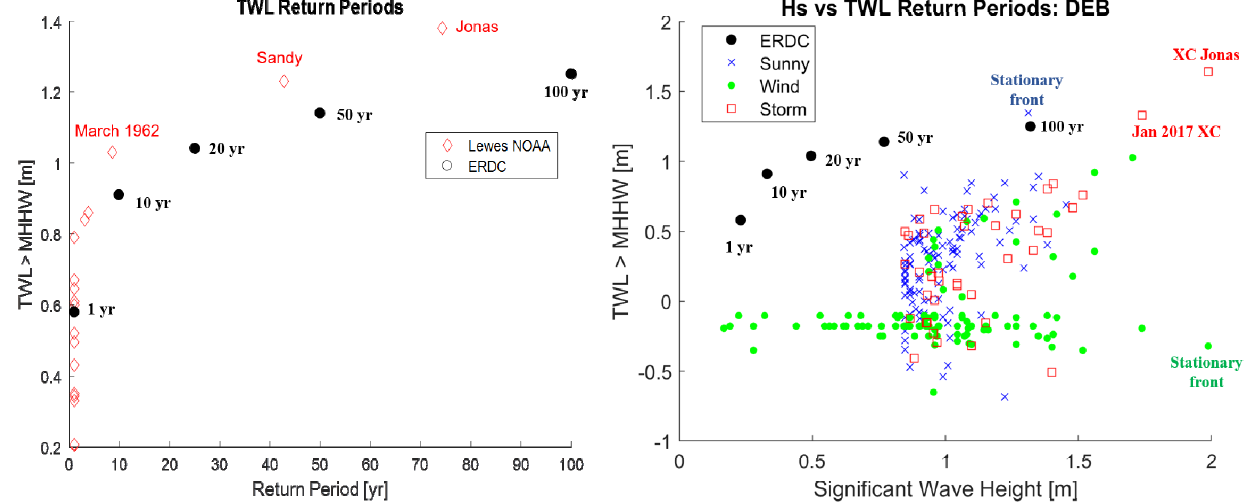
Figure 7. ( Left ) Return period plot of the total water level above MHHW for the Lewes gauge station for a selection of historical storms compared to the statistical return period values created by USACE ERDC during the NACCS project. See Appendix B for a list of storm names, dates, and values used in this figure. ( Right ) ERDC return period values for H s and TWL MHHW plotted with corrected WW3 wave heights, NOAA tide station water levels, and U 10 wind speeds from 2015 to 2019.